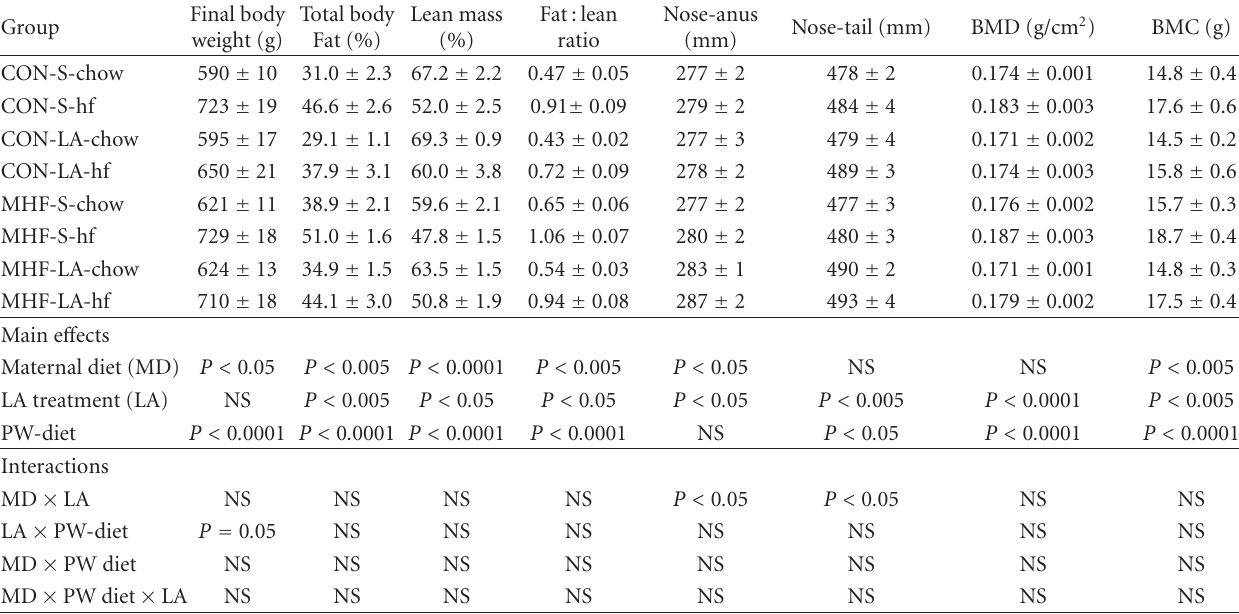
Table 1: Adult (P110) body weight, total fat (%), body length, bone density, and mineral content in CON or MHF o ff spring treated with either saline (S) or pegylated leptin antagonist (LA) as neonates and fed either a chow or hf diet after weaning. Data are means ± SEM, n = 8–16 per